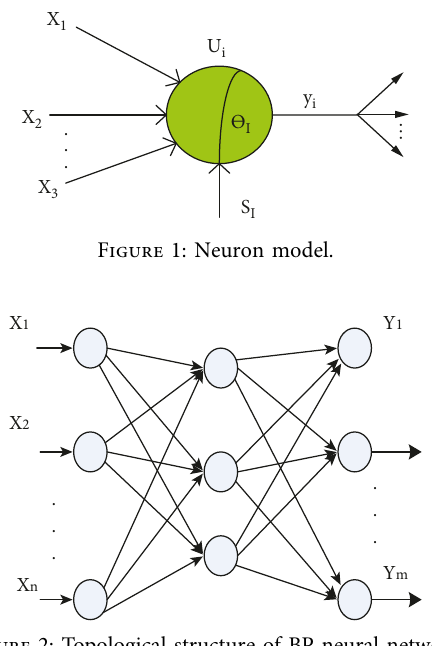
Figure 2: Topological structure of BP neural network.